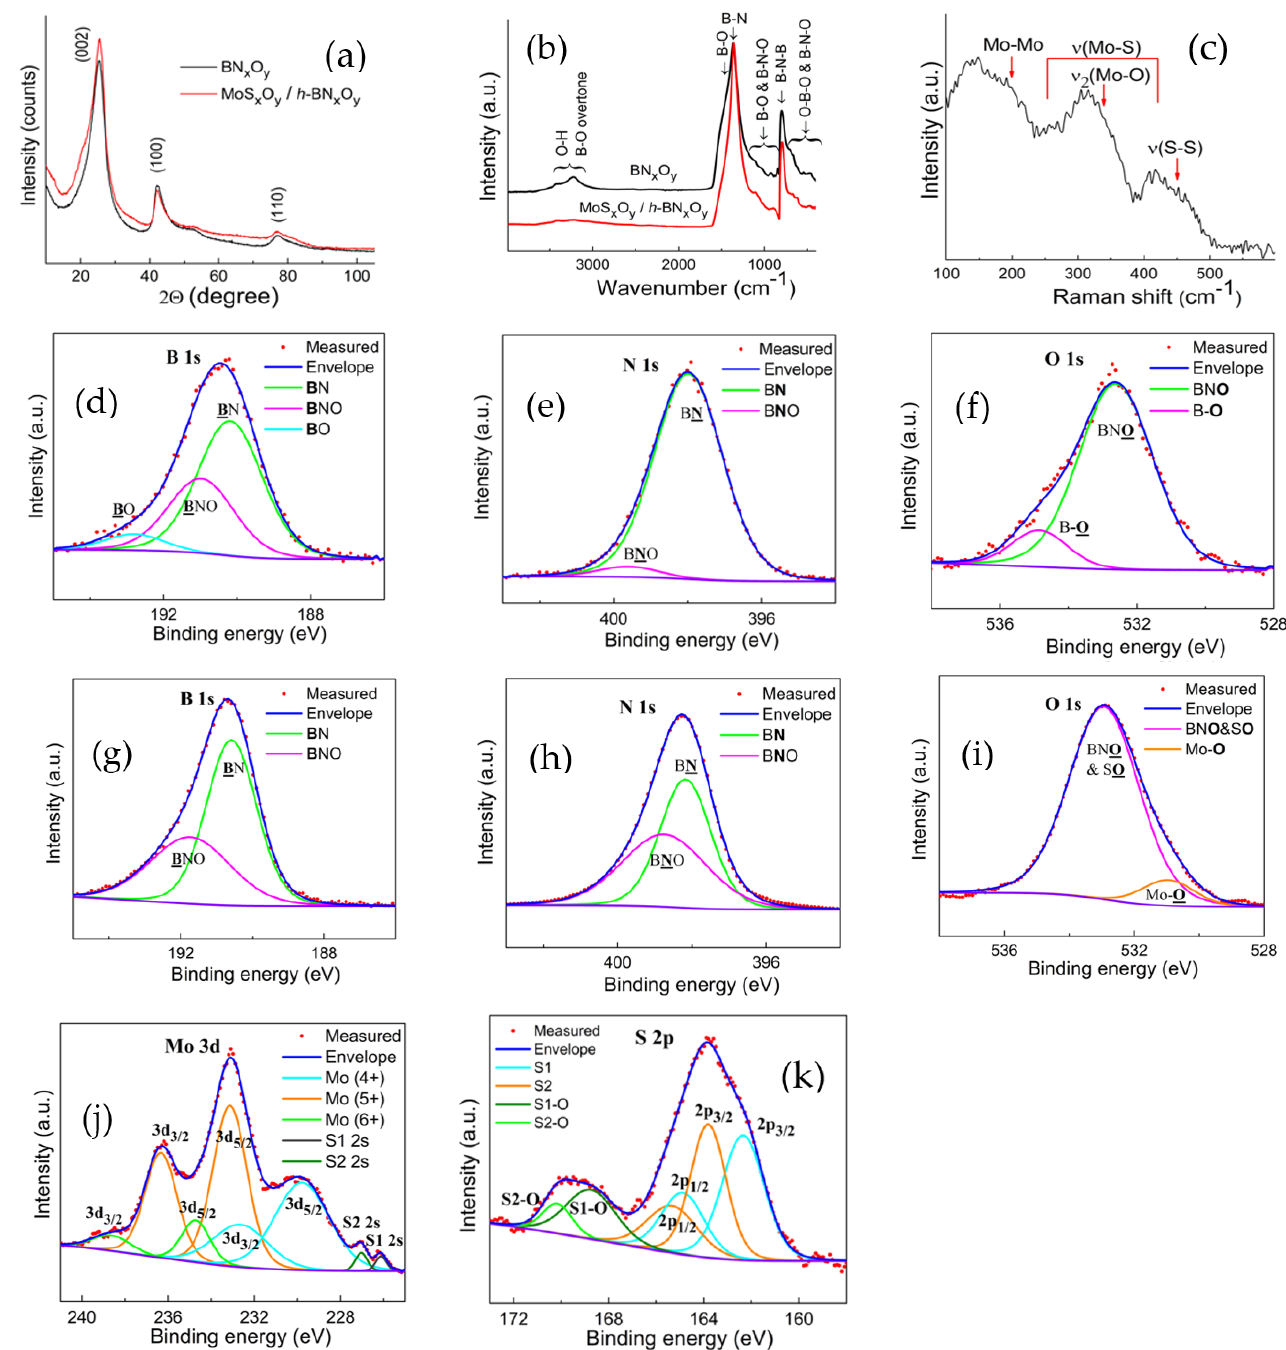
Figure 2. XRD patterns ( a ) and FTIR ( b ), Raman ( c ), and XPS ( d – k ) spectra of h -BN x O y and a -MoS x O y / h -BN x O y materials. h -BN x O y —( a , b , d – f ), a -MoS x O y / h -BN x O y —( a – c , g – k ).